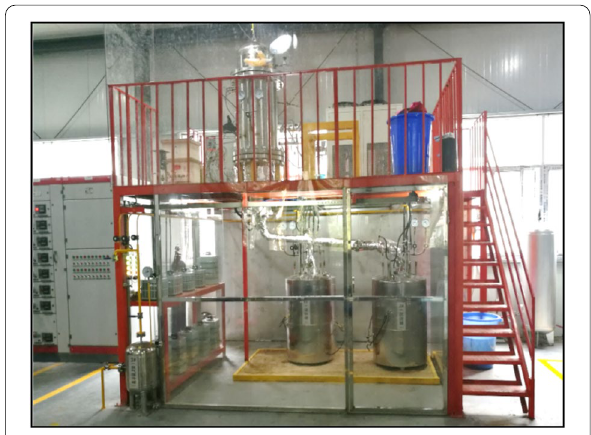
Fig. 8 Test facility of melt fragmentation in sodium